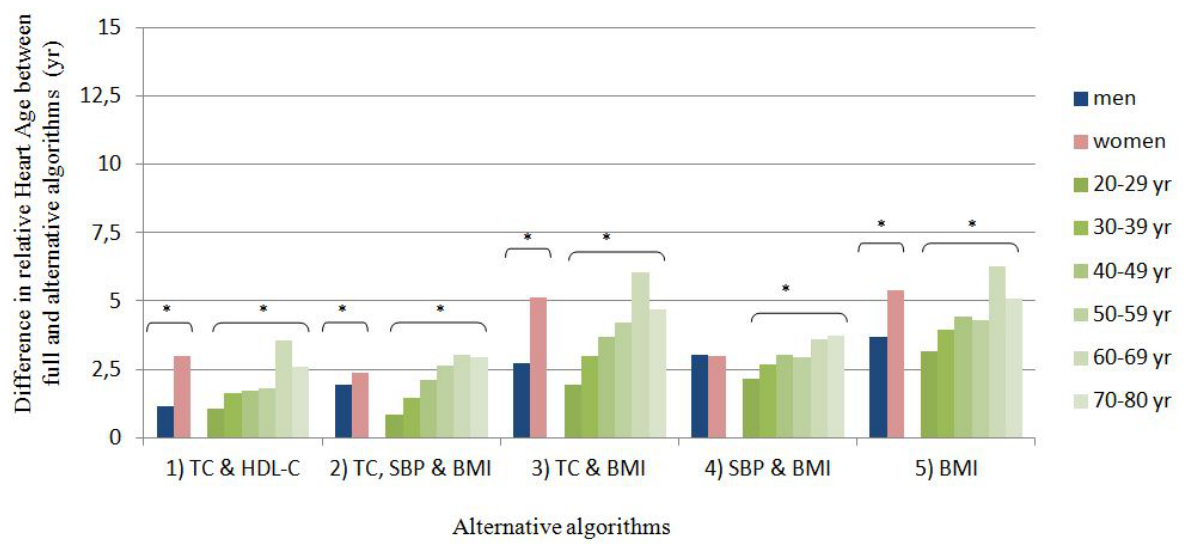
Figure 2. Mean difference in relative Heart Age (i.e. the difference between users’ Heart Age and chronological age) between the full and alternative algorithms per gender and age category. The analysis was restricted to a sub-sample of users with complete valid values for total cholesterol (TC), HDL-cholesterol (HDL-C), systolic blood pressure (SBP) and BMI (n=173,397), and adjusted for age, gender and country where appropriate. Means are estimated marginal means. * significantly different, p <